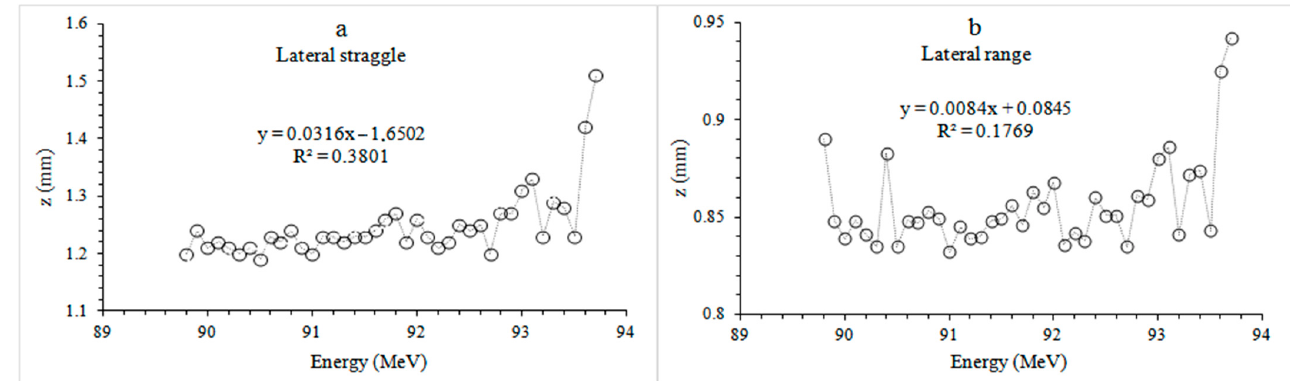
Figure 6. Recoils curves of different energy proton beams in tooth plate molar phantoms. ( a ) Lateral straggle ( b ) Lateral range. Circles indicate lateral straggle and range for different energy levels.